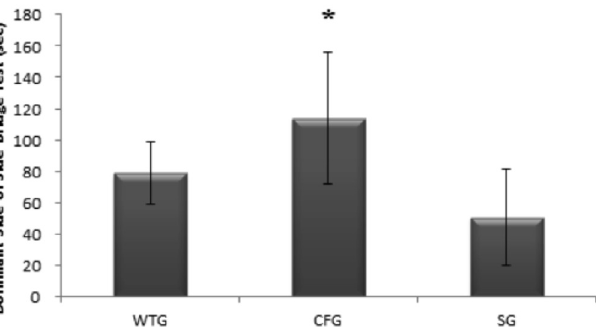
Figure 1. Mean and standard deviation of the of the side bridge test endurance time regarding the dominant